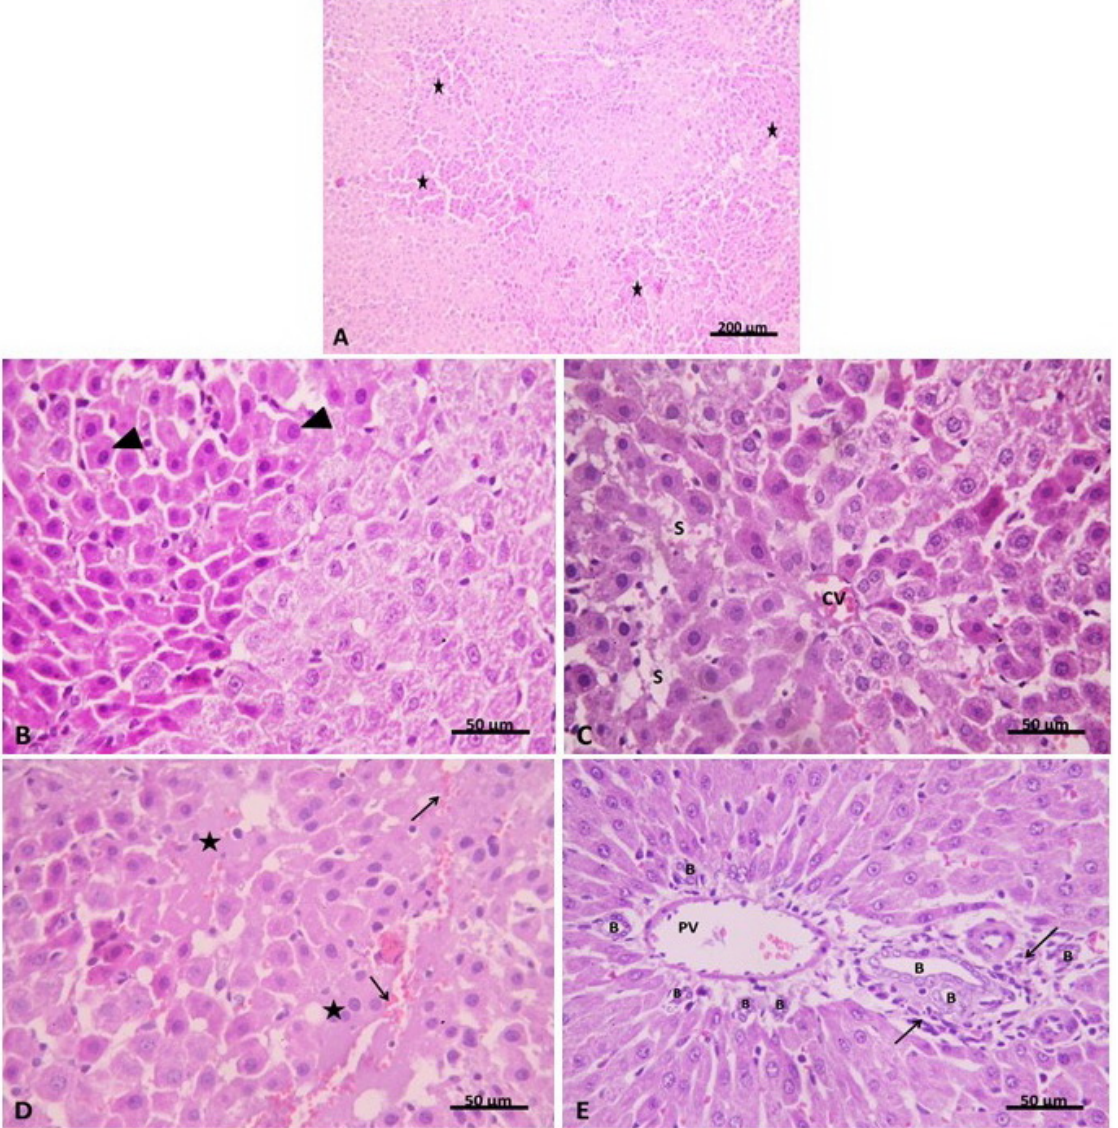
Figure 6. ( A ) showing disruption of the normal hepatic architecture with focal areas of deeply stained cells (*). ( B ) Group II. H&E x100 showing the focal area of hepatocytes with deep acidophilic cytoplasm and small dark nuclei pushed peripherally in some cells ( ▲ ). ( C ) Group II. H&E ×400 showing congested central vein (CV). The radiating hepatocytes appeared with deep acidophilic cytoplasm and small dark nuclei. Notice the dilated blood sinusoids (S). ( D ) Group II. H&E ×400 showing areas of hemorrhage ( ↑ ) and areas of homogenous acidophilic material (*) between hepatocytes. ( E ) Group II. H&E ×400 showing an expanded portal tract with the dilated portal vein (PV) and proliferation of the bile ducts (B). Mononuclear cellular infiltration is also evident ( ↑ ). Group II. H&E ×400.